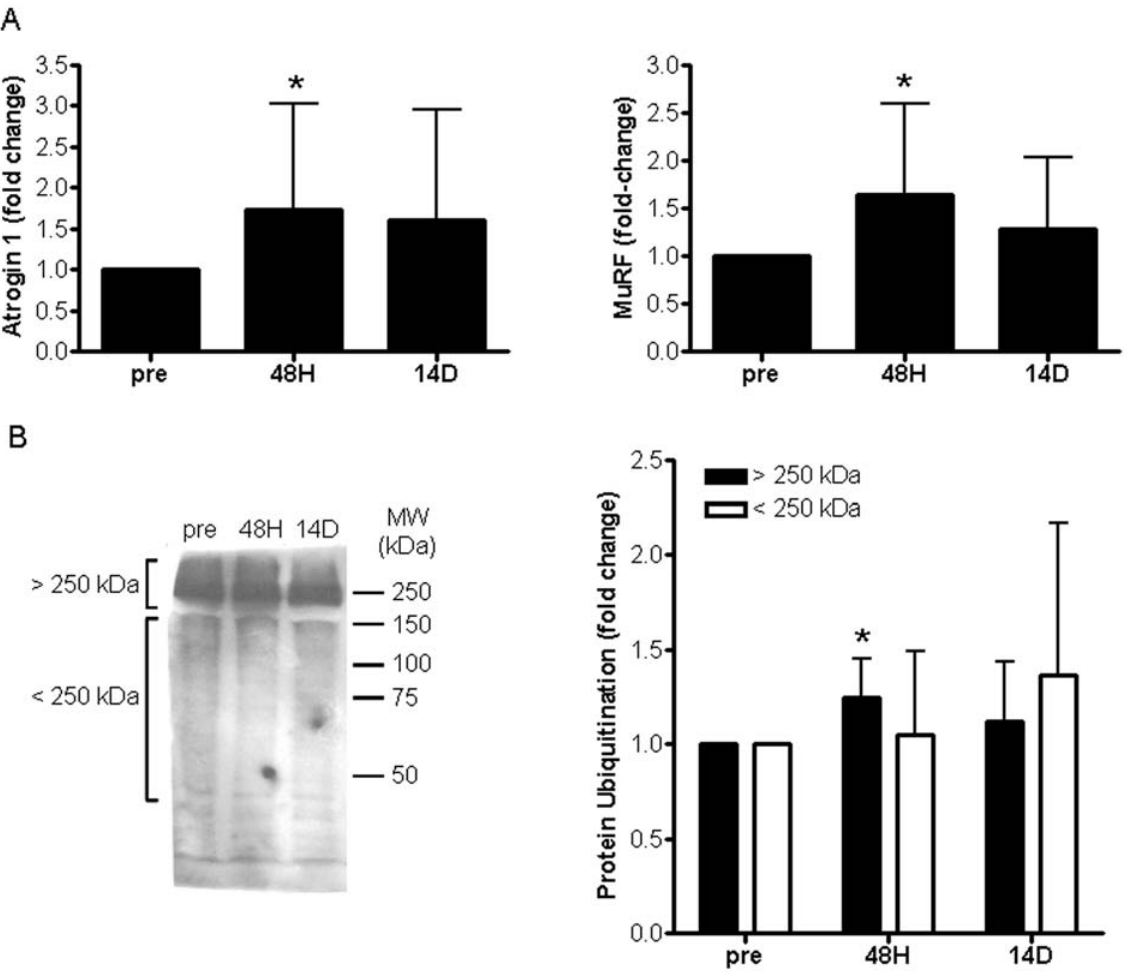
Figure 4. Transcriptional status of atrogin-1 and MuRF-1 and global protein ubiquitination during immobilization-induced muscle atrophy. (A) The mRNA level of both atrogin-1 and MuRF-1 was determined using qRT-PCR and significant (P # 0.05) increases in both genes were detected following 48 H of immobilization but not at 14 D. (B) Overall protein ubiquitination was examined using Western blotting and numerous ubiquitin-positive protein bands were detected (left). The most ubiquitin-dense proteins were greater than 250 kDa in MW. Thus lanes were divided into high MW ( . 250 kDa) and low MW ( , 250 kDa) sections and quantified using densitometry. A significant (P # 0.05) increase in protein ubiquitination of high MW proteins was detected following 48 H of immobilization (right, asterisk) but not 14 D. No significant changes in low molecular weight ( , 250 kDa) protein ubiquitination were detected at any time-point.